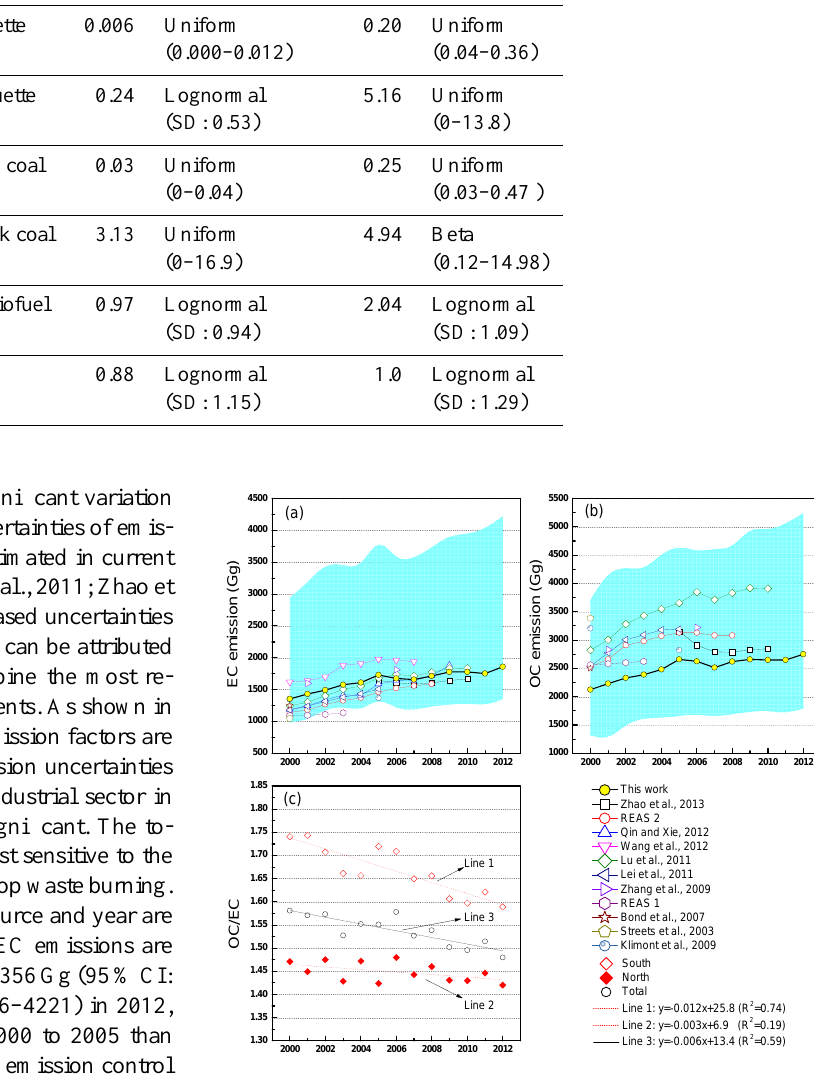
Figure 2. Inter-annual trends of (a) EC emissions, (b) OC emis- sions, and (c) ratios of OC to EC emissions, (OC / EC) emi , for China from 2000 to 2012. The blue area indicates the 95% CIs estimated by this work. The definition of southern and northern provinces is indicated in Fig.